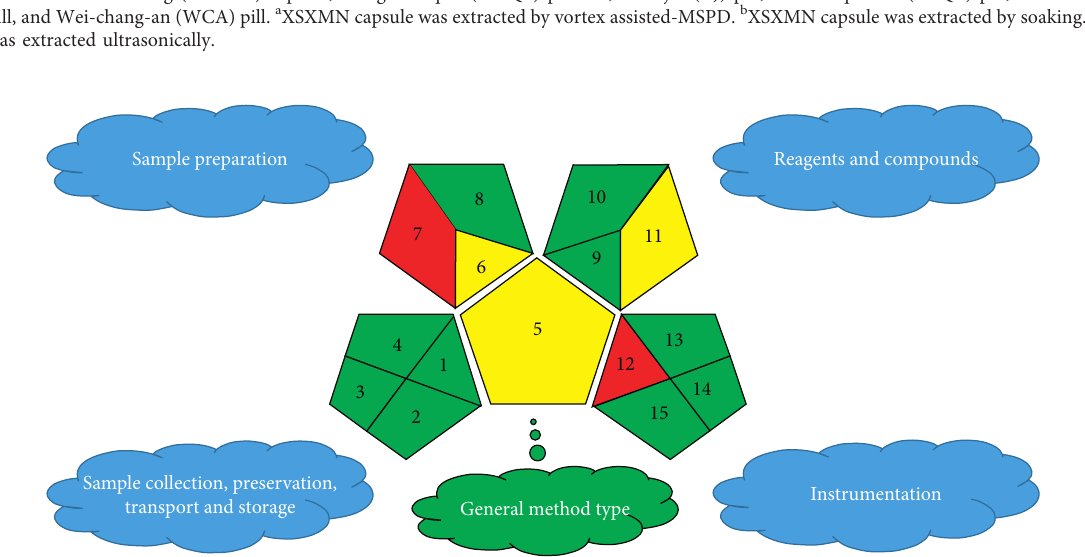
Figure 5: GAPI assessment of the green profile of the evaluated procedures for determining four targets in musk and its Chinese